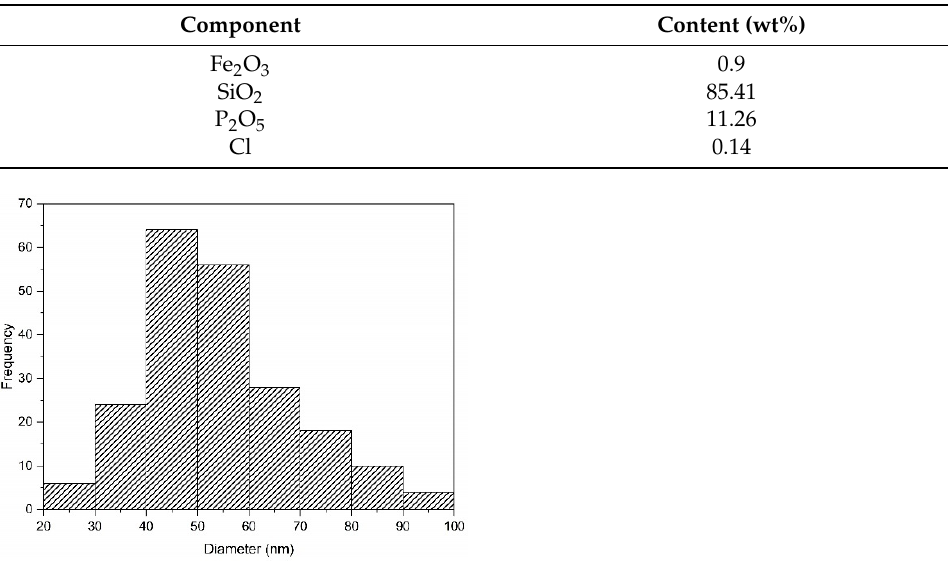
Table 5. Composition of purified silica after cleaning with deionized water. It was measured using XRF.